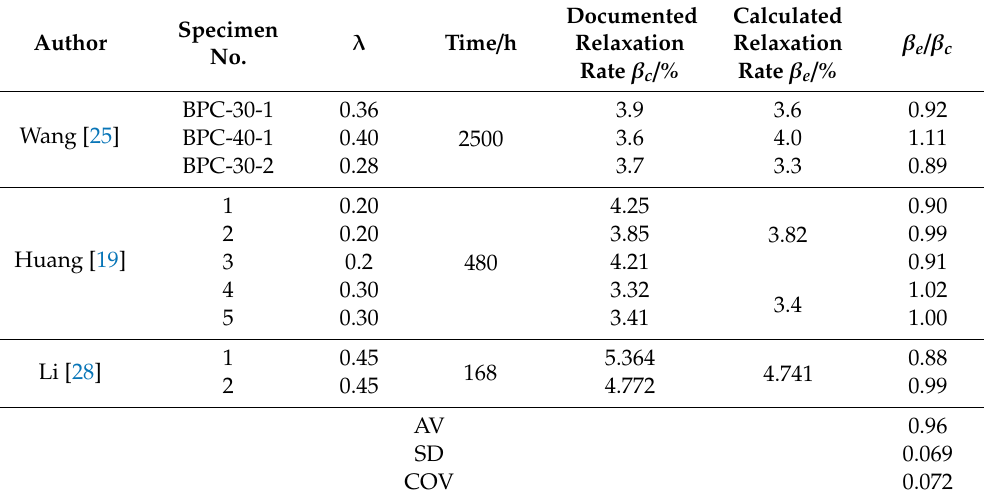
Table 9. Comparison of experimental results in di ff erent